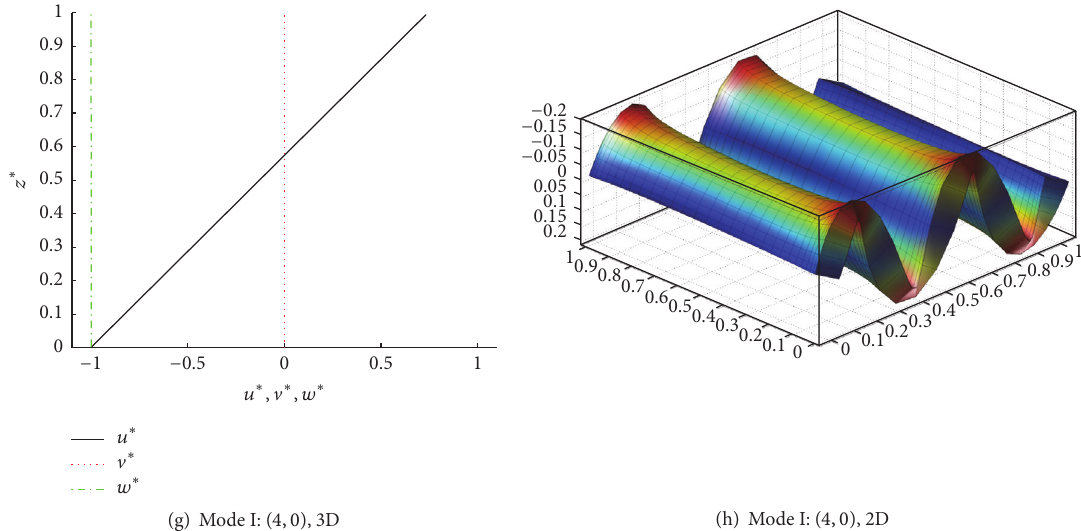
Figure 3: First four cylindrical bending vibration modes for the 𝑎/ℎ = 20 one-layered FGM plate with 𝑝 = 0.5 . 3D modes versus 2D modes.